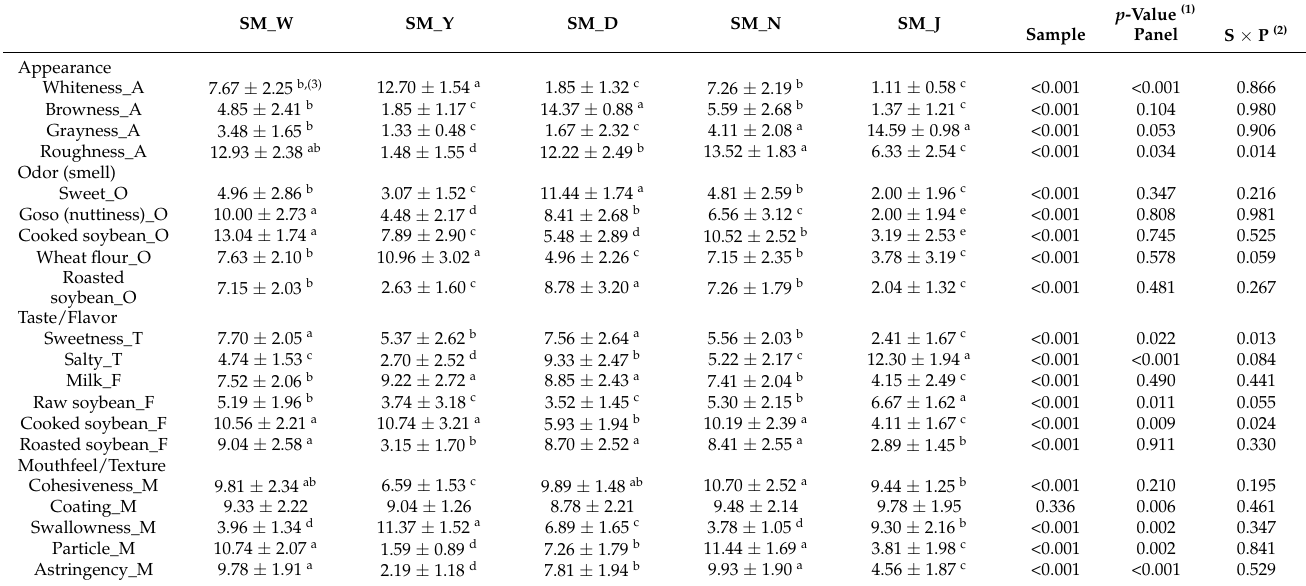
Table 3. Intensities of the descriptive attributes for five soymilks.